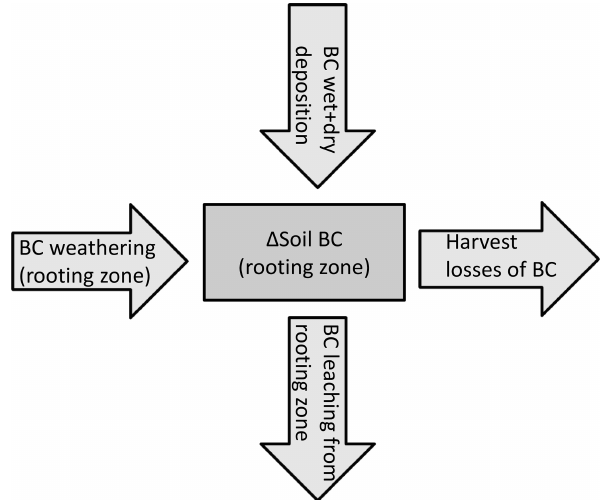
Figure 1. Base cation (BC) mass balance for the rooting zone of a well-drained forest soil. (cid:49) Soil BC is the sum of the net change in BC in soil solution, the net change in soil exchangeable BC and the net change in soil organic material